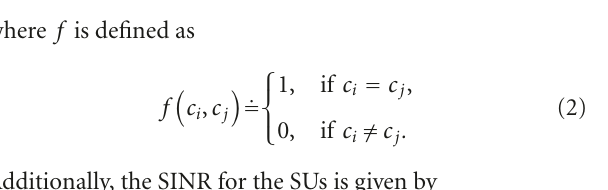
Figure 2: Half-duplex relaying scheme for secondary users. Each user chooses one slot to listen to the primary and retransmits in the following slot. Secondary users choose in which slot to transmit as a part of their